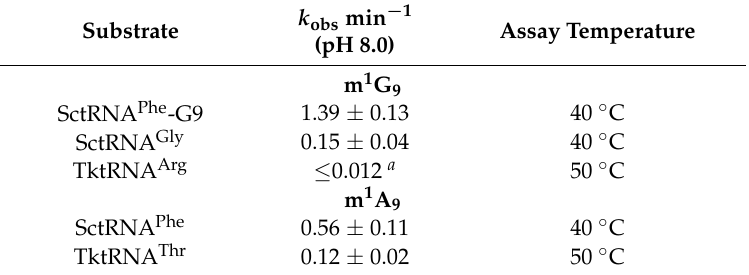
Table 1. Substrate dependent differences in single turnover methylation rate by